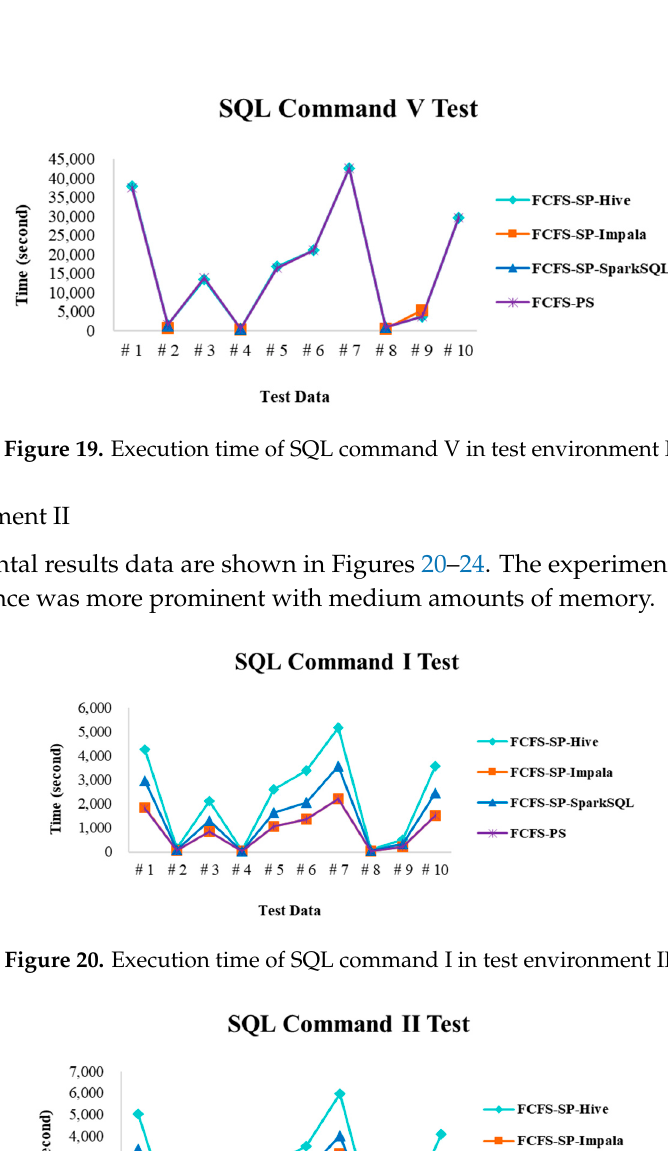
Figure 18. Execution time of SQL command IV in test environment I.